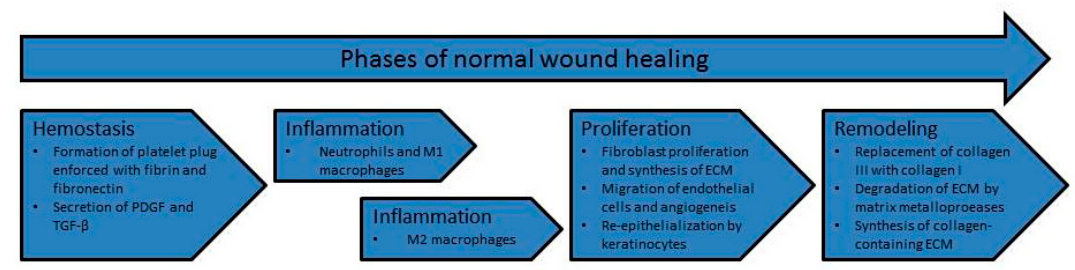
Figure 1. The phases of normal wound healing. Wound healing normally progresses through a tightly orchestrated process that is usually described as having four overlapping phases. During hemostasis, a platelet plug is formed and growth factors are secreted. The inflammatory phase has two stages. The initial stage, where neutrophils and pro-inflammatory M1 macrophages prevail, and a second stage characterized by the presence of anti-inflammatory M2 macrophages. During the proliferation phase, fibroblasts proliferate and synthesize extracellular matrix (ECM), new vessels are formed, and keratinocytes re-epithelialize the surface of the wound. In the final remodeling stage, the composition of the ECM is altered through degradation and resynthesis. PDGF: platelet-derived growth factor; TGF- β : transforming growth factor- β .